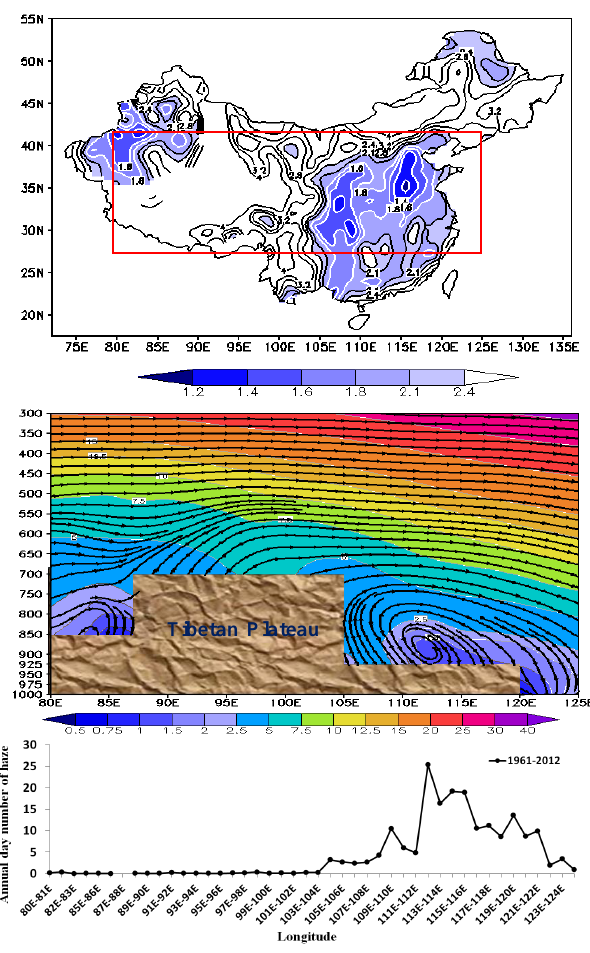
Figure 3. Near-surface wind speed distribution (ms − 1 ) averaged over 1961–2012 in China with the red rectangle marking the region for cross sections in the middle and lower panels (upper panel). Cross sections of horizontal wind speed (ms − 1 ; filled color con- tours) and vertical circulations illustrated by stream lines (mid- dle panel) and zonal variations of annual haze event frequency (lower panel) at 27–41 ◦ N averaged over 1961–2012. Note that near-surface vertical and horizontal winds are not illustrated well here due to north–south variations in the terrain and approximation of the location of the TP in this figure. All fields are for the annual